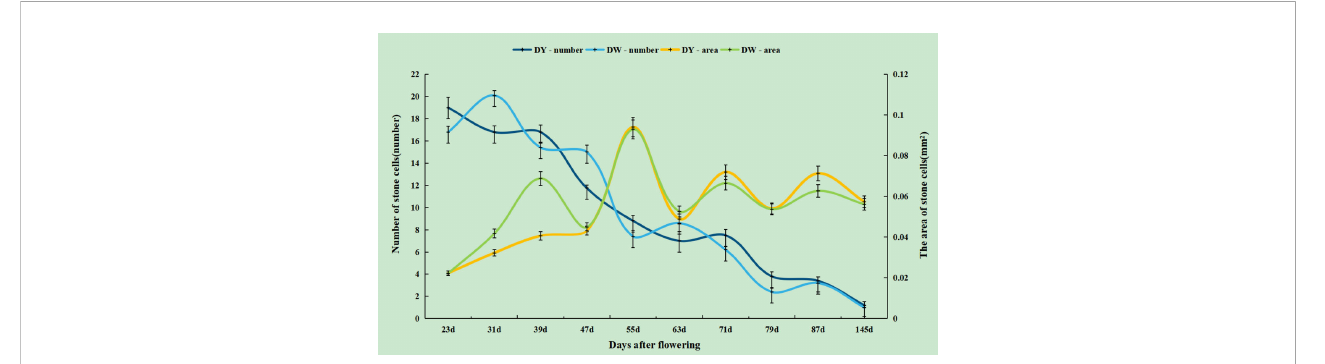
FIGURE 4 The number and area of stone cell clusters during different developmental stages of DY and